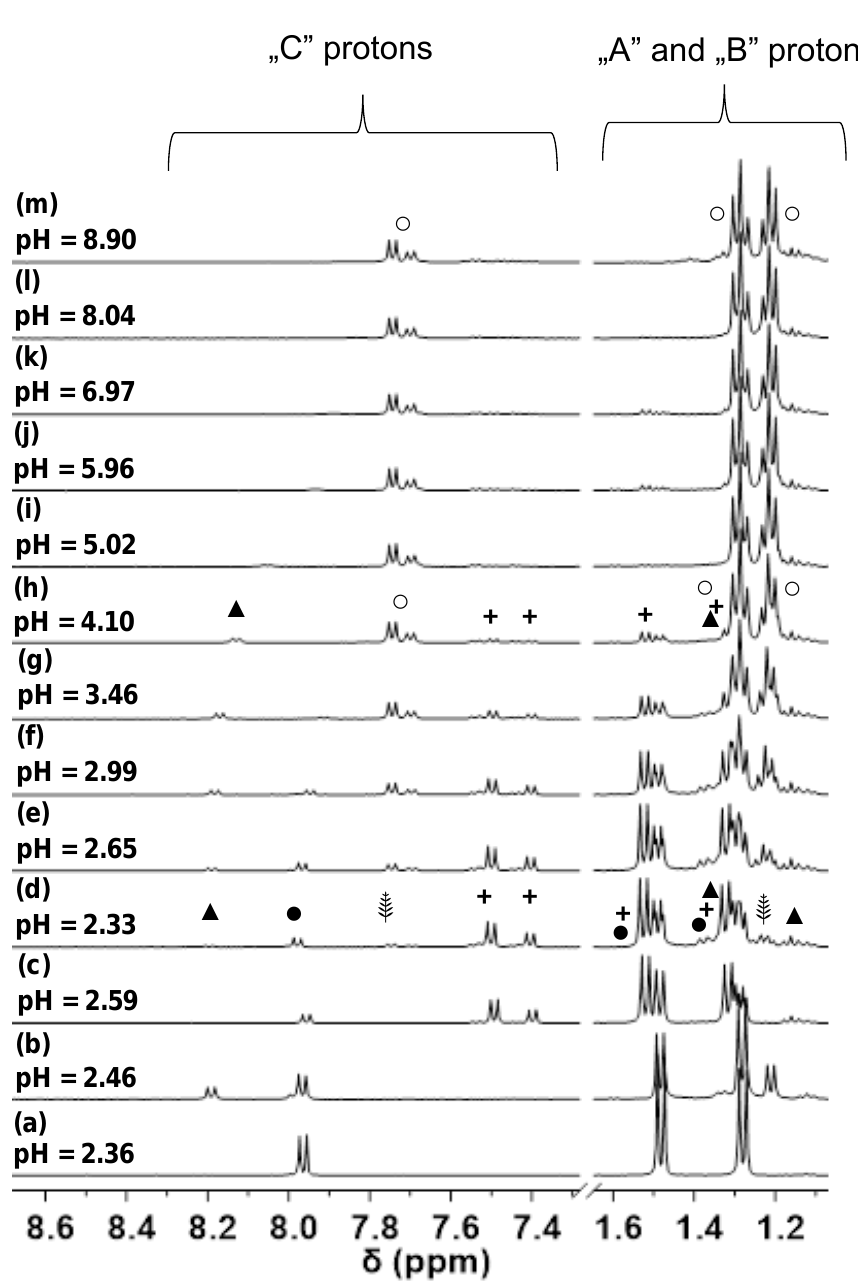
Figure 4. 1 H NMR spectra registered for the H + – (L1) − ( a ) and [Co(tren)] 3+ – (L1) − system ( b – g ) at dif- ferent pH Figure 5. 1 H NMR spectra registered for the H + –(L1) − ( a ), the Pd(II)–(L1) − ( b ), or [Co(tren)] 3+ –(L1) − ( c ) monometallic and the Pd(II)–[Co(tren)] 3+ –(L1) − ( d – m ) bimetallic systems at different pH values. Symbols represent the signals belonging to the following species: [H 3 (L1)] 2+ (●), [PdHL] 2+ ( ▲ ), (cid:32) [Co(tren)] 3+ (+), [PdH –1 LCo(tren)] 3+ (